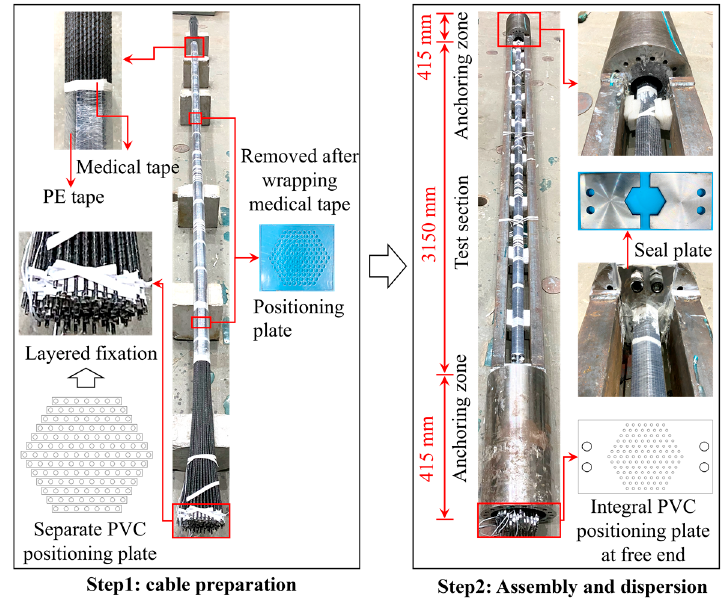
Figure 10. Preparation of dispersed-tendon CAS.